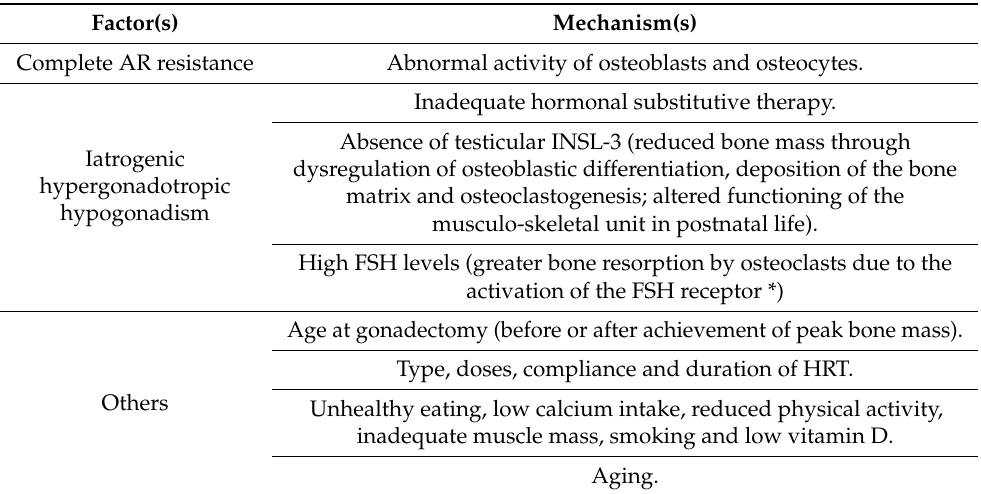
Table 3. Main data on bone mineral density (BMD) status in women with CAIS (single case reports are not